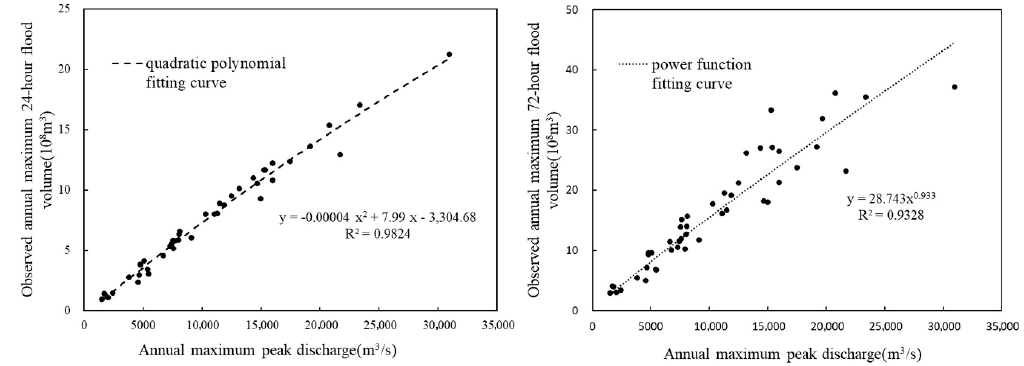
Figure 3. Correlation relationship between the flood peak and volume at the Ankang hydrological station.